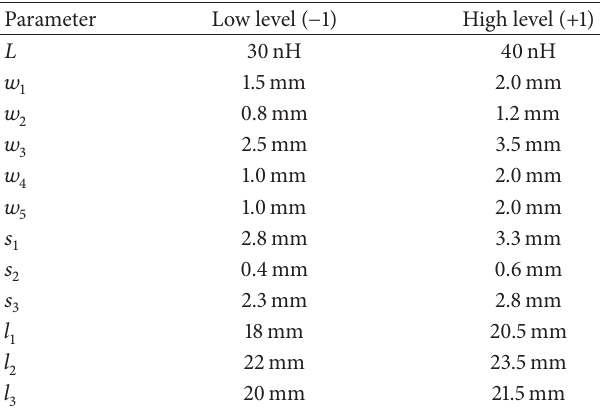
Table 7: Ranges for the design parameter of the internal antenna for LTE handheld